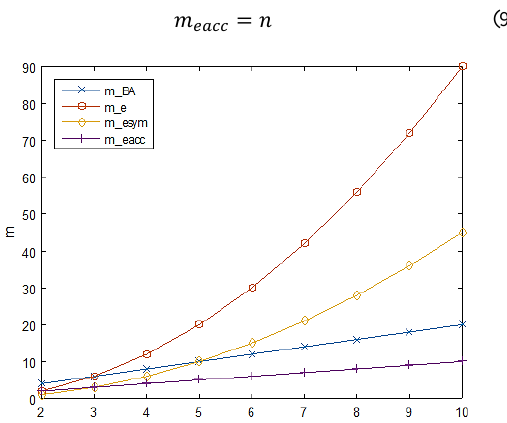
Figure 1. Resulting number of equations 𝑚 against the number of projections 𝑛 of a point for different cost functions. For classical bundle adjustment (blue) m grows linearly, whereas it grows quadratically for standard epipolar formulations (red: single epipolar distance, yellow: symmetric epipolar distance).